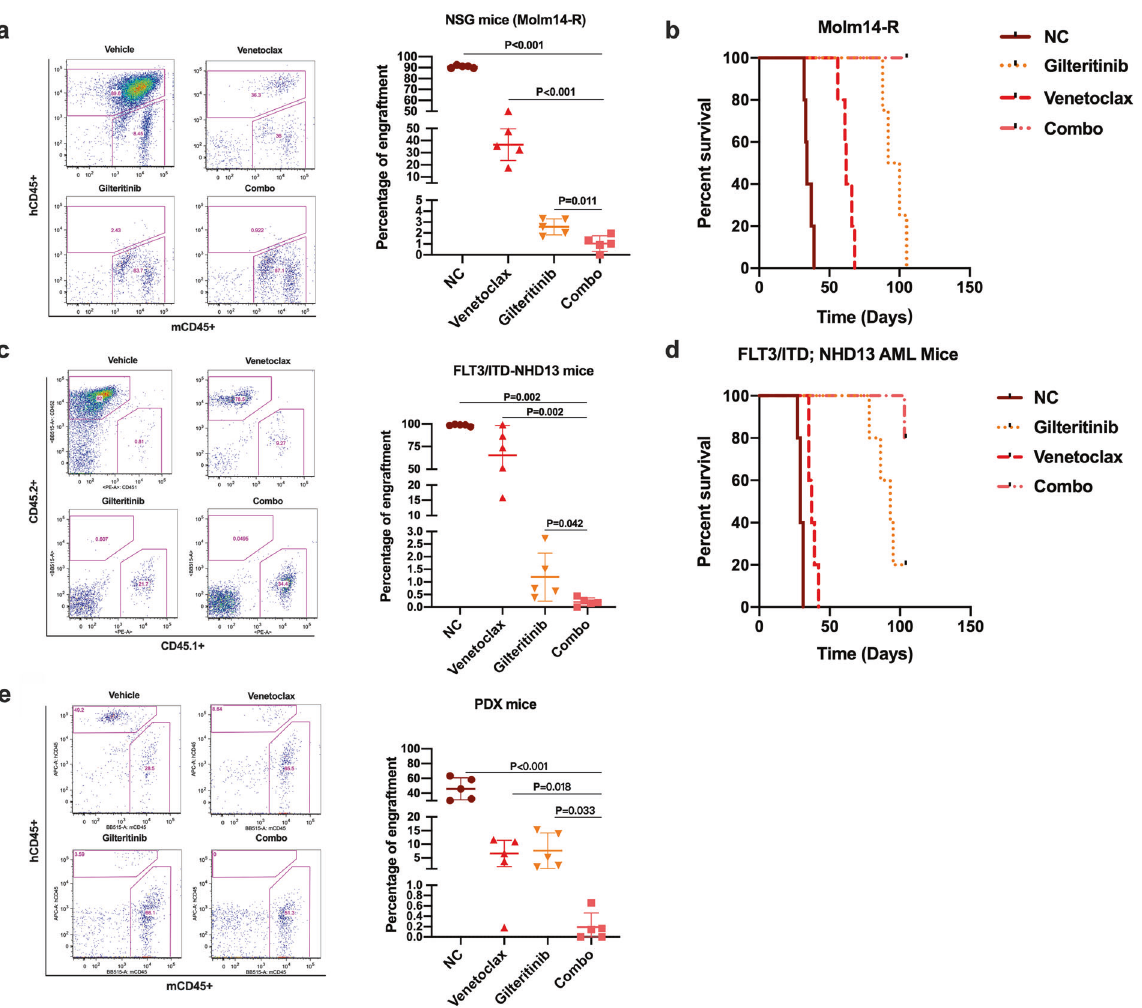
Fig. 7 Gilteritinib and Venetoclax combine to more effectively eliminate FLT3/ITD cells in vivo. Mice were treated with vehicle, Gilteritinib (15 mg/kg/day), Venetoclax (80 mg/kg/day), or the combination via oral gavage for various length of time. a , b Engraftment in BM and Kaplan – Meier survival curve for Molm14-R transplanted mice; c , d Engraftment in PB and Kaplan – Meier survival curve for FLT3/ITD;NHD13 transplanted mice; e Engraftment of human CD45 + cells in the BM of PDX